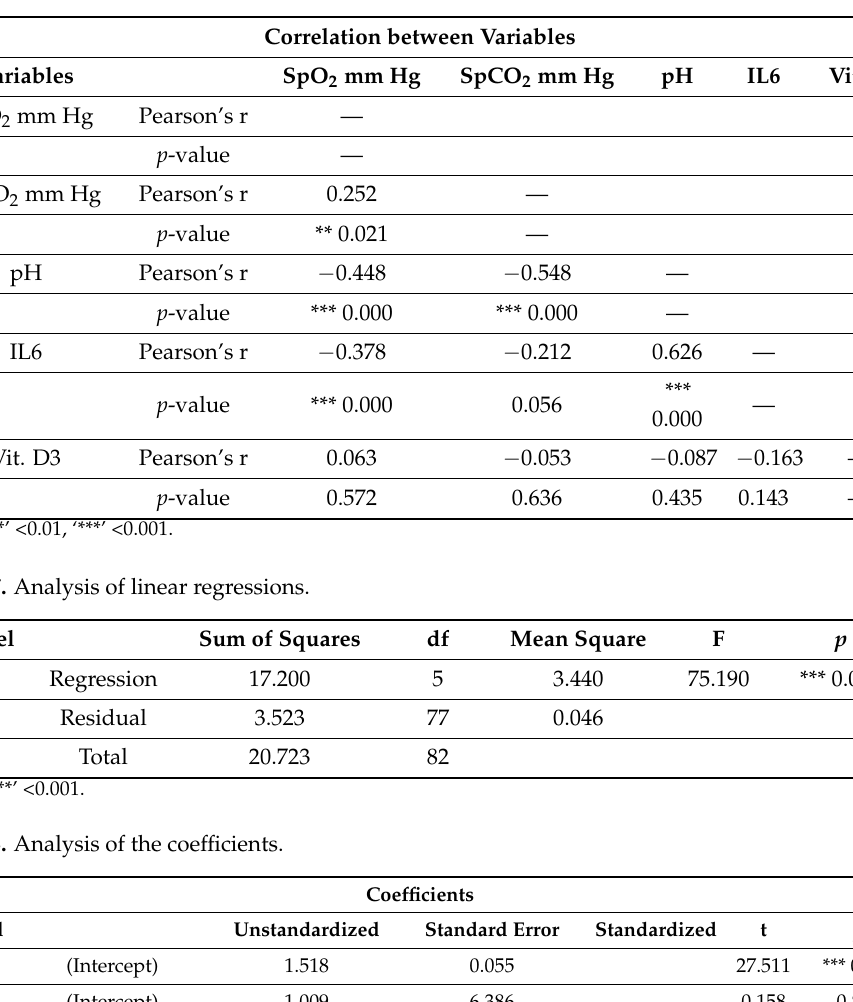
Table 6. Analysis of the correlation between variables and healthy vs. COVID-19 infected status (see the relevance/contribution of each factor when all together—ABG’s values and IL6 with Vit.3).